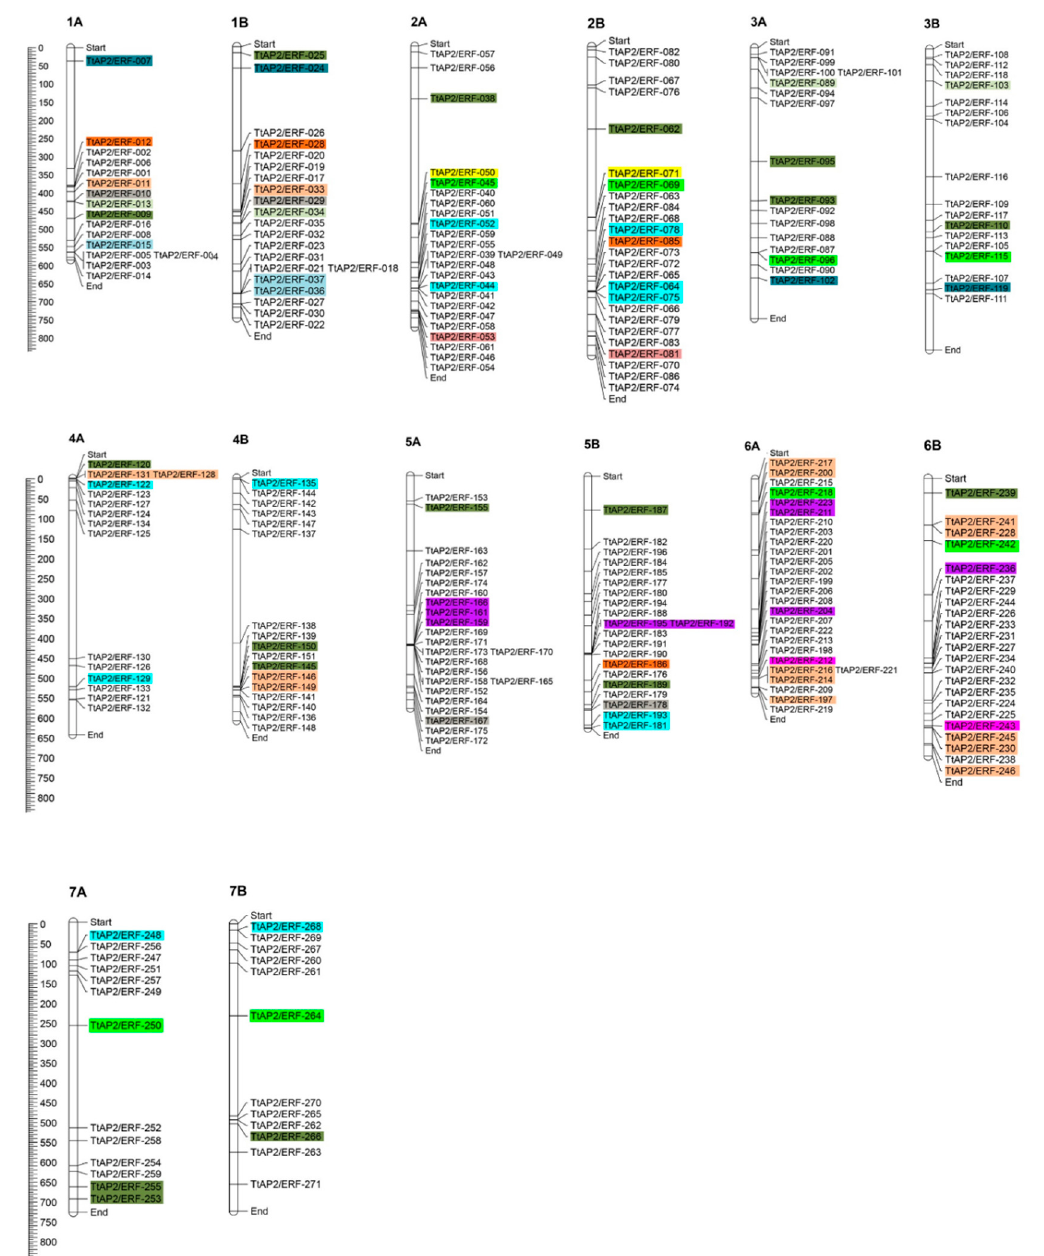
Figure 2. Chromosomal distribution of 271 non-redundant putative TtAP2 / ERF genes predicted from the T. turgidum genome. The predicted duplicated pairs are highlighted in the same color.